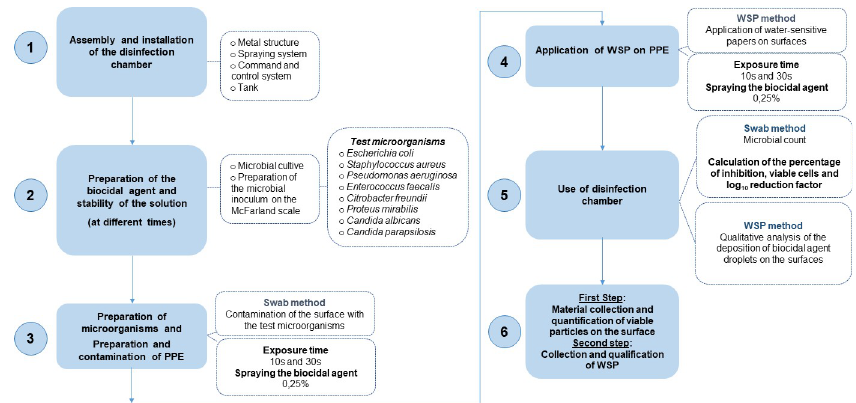
Fig 1. Schematic illustrating the method used in this study to evaluate the spray disinfection technology for instant decontamination of personal protective equipment.